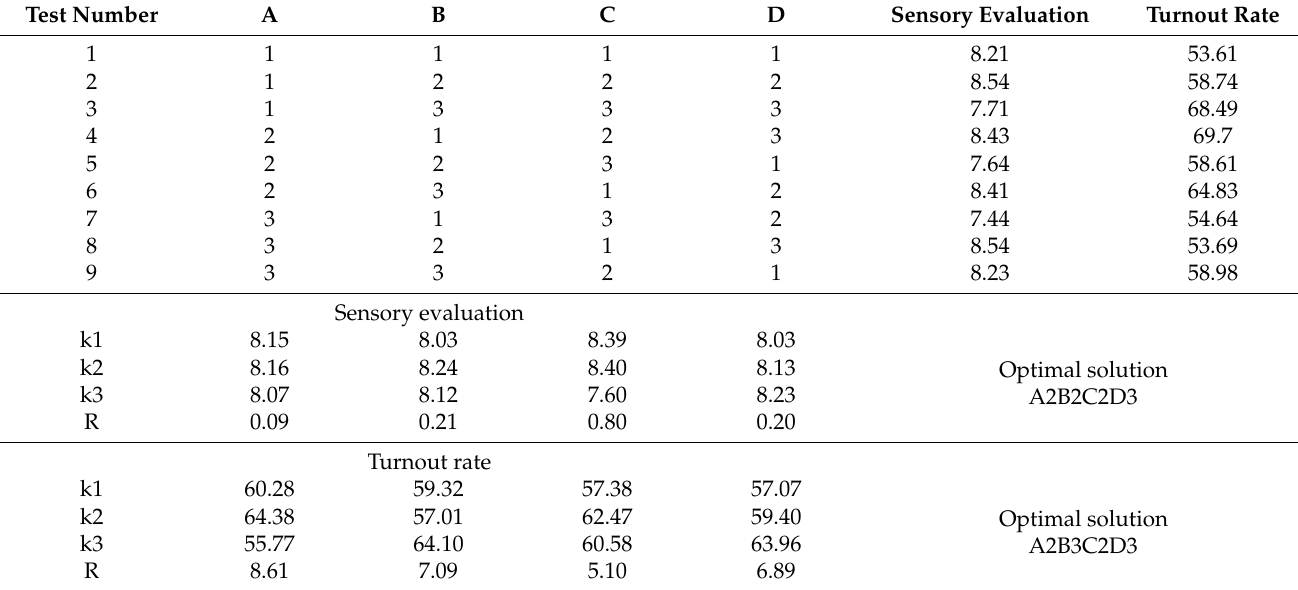
Table 3. Orthogonal experiment results of formula and technology of ST